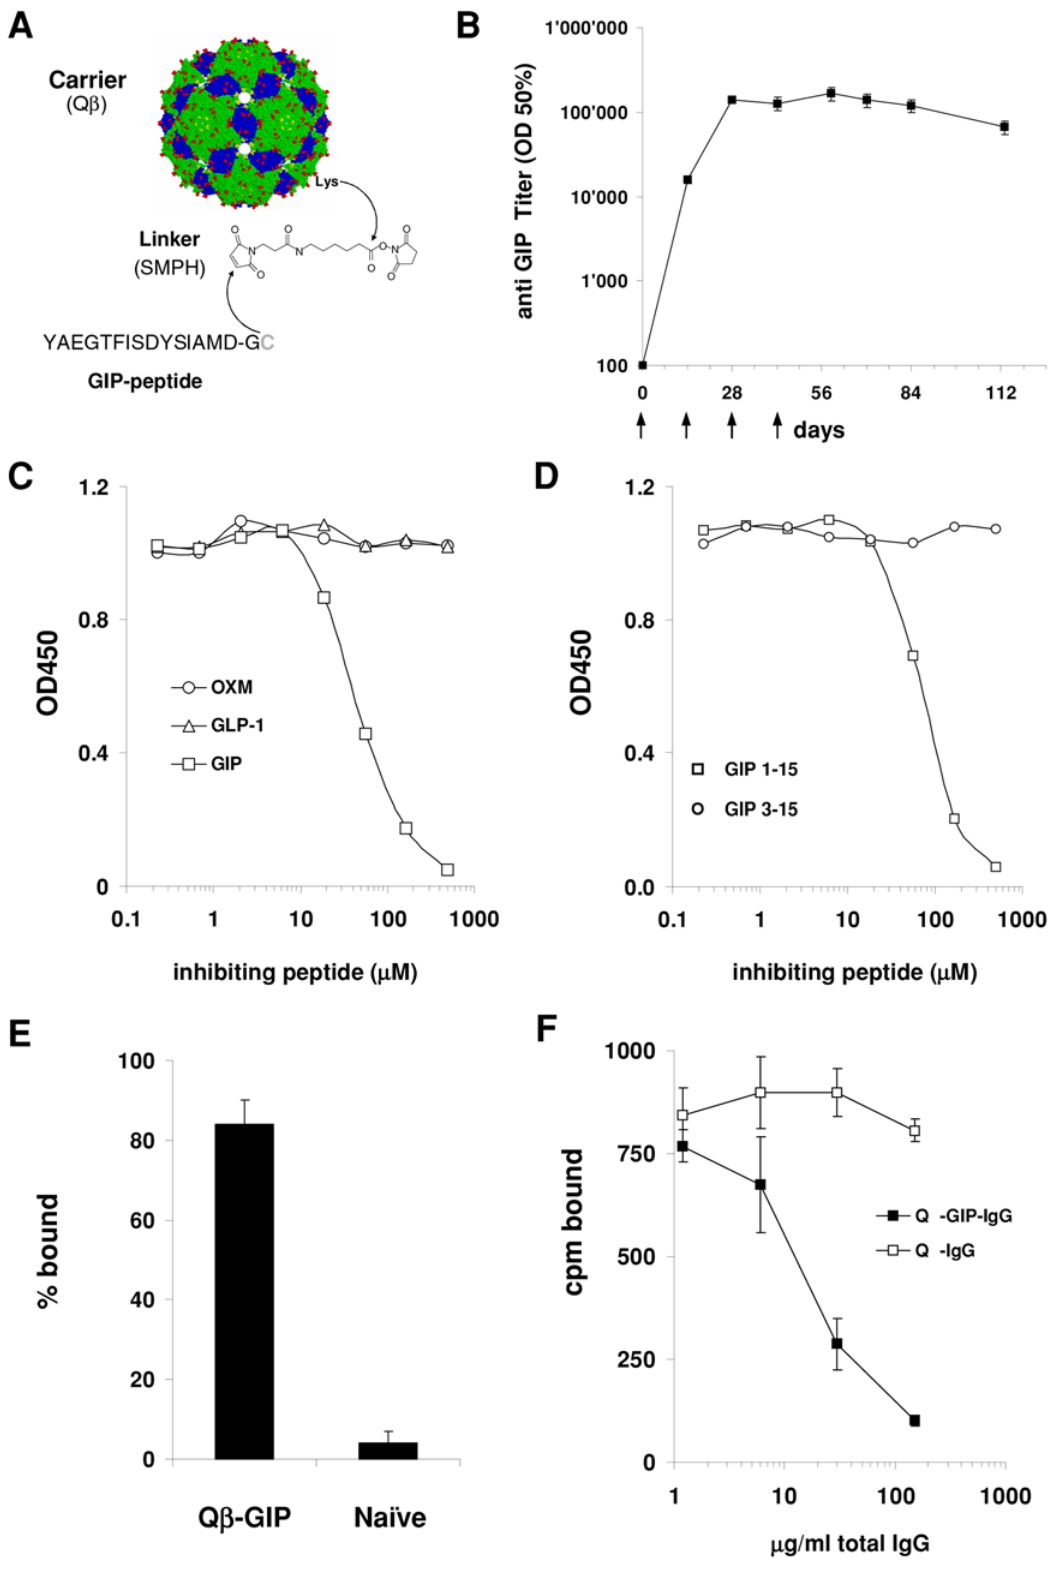
Figure 1. Vaccination against GIP results in high, specific antibody titers. (A) Schematic diagram of GIP peptide coupling to Q b VLPs. GIP peptides (aa 1–15), corresponding to the N-terminus of the active peptide, were covalently linked to Q b VLPs via an SMPH linker. (B) GIP-specific antibody titers in vaccinated mice. Female mice were immunized s.c. with 100 m g of Q b -GIP (days 0, 14, 28 and 42). Average GIP-specific antibody titers 6 SEM (n=6) at the indicated time points are shown. (C) Cross-reactivity of GIP-specific antibodies. A serum pool from Q b -GIP-immunized mice